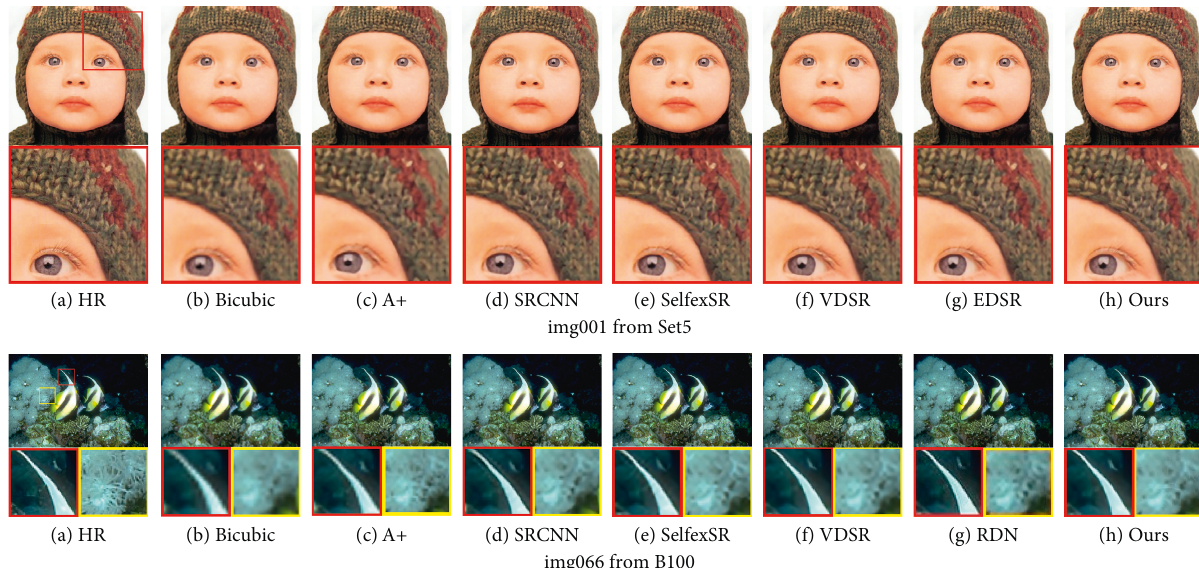
Figure 8: Super-resolution results for scale factor 3. Below each image is a partial